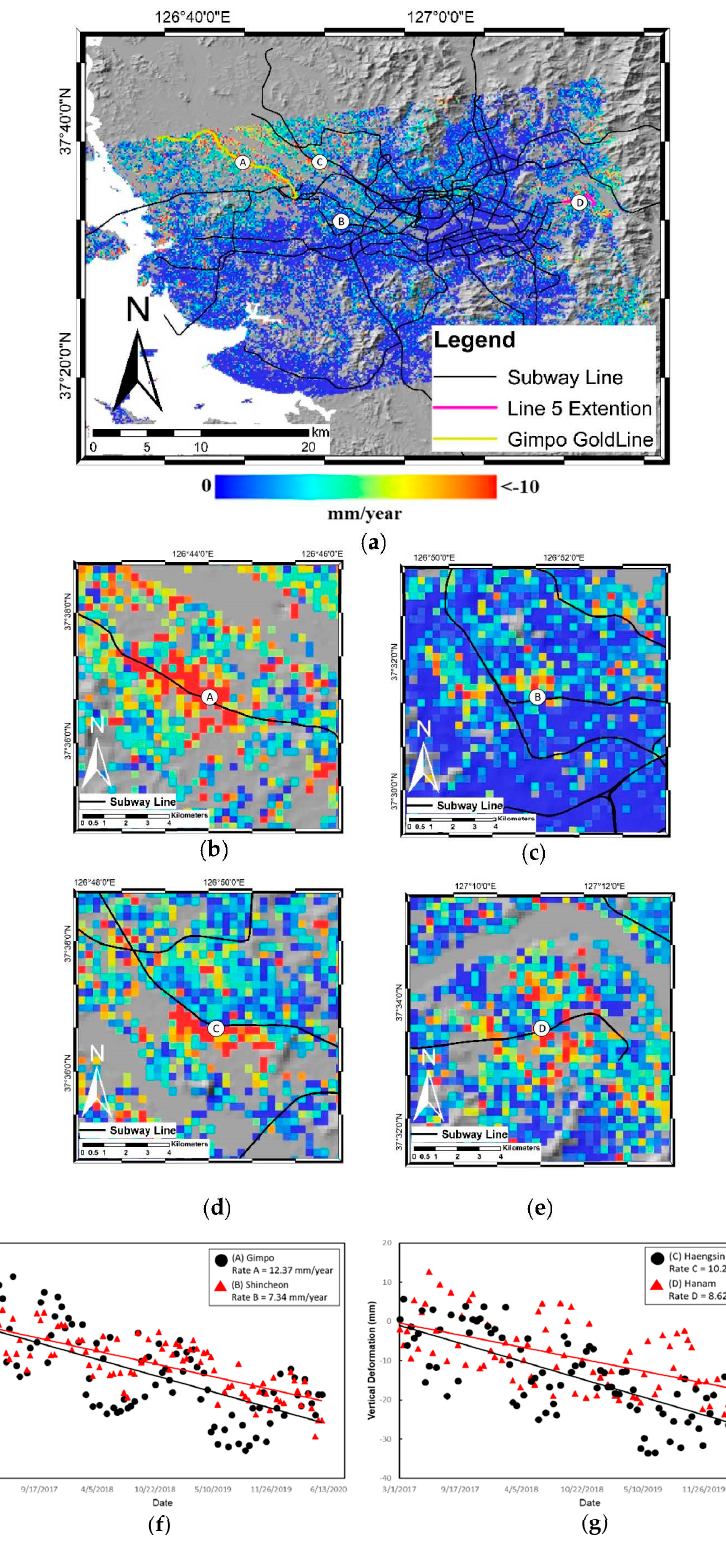
Figure 4. ( a ) Mean vertical deformation map in descending track of the Seoul Metropolitan Area generated from a Hillshade image comprising digital elevation model data from the Shuttle Radar Topography Mission. ( b ) Zooming of vertical deformation map at points A (Gimpo), ( c ) point B (Shincheon), ( d ) points C (Haengsin) and ( e ) points D (Hanam), ( f ) Vertical deformation time-series at points A (Gimpo) and B (Shincheon), and ( g ) points C (Haengsin) and D